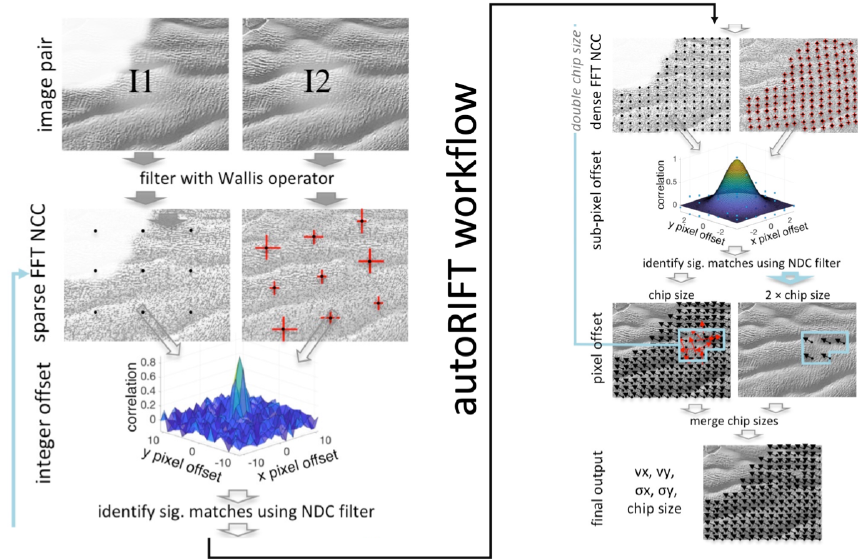
Figure 3. Composite diagram showing the autoRIFT